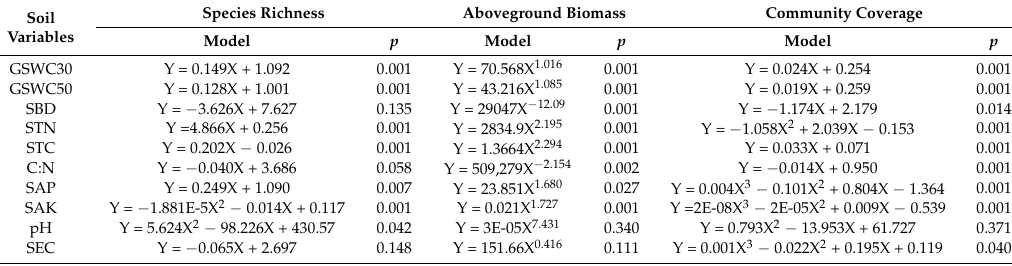
Table A1. Regression equations of species richness, aboveground biomass, community coverage and soil properties. Abbreviations: GSWC30, soil water content (0–30 cm); GSWC50, soil water content (30–50 cm); SBD, Soil bulk density; STN, soil total nitrogen; STC, soil total carbon; C:N,